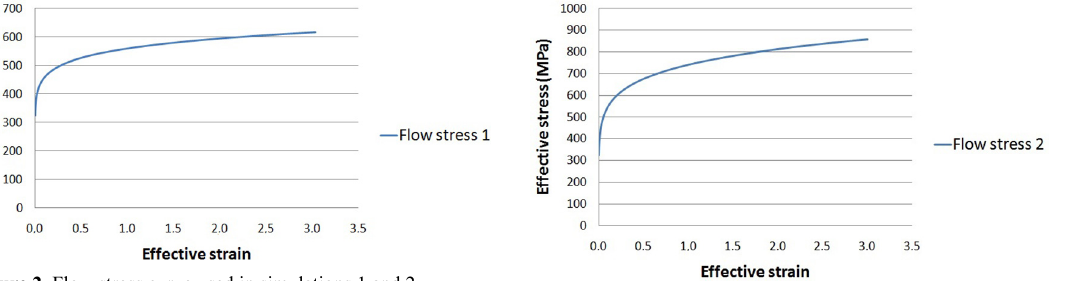
Figure 2. Flow stress curve used in simulations 1 and 2.